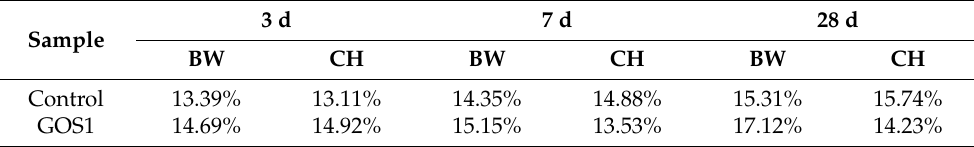
Table 5. Chemical binding water and CH content of reference sample and GOS sample at different